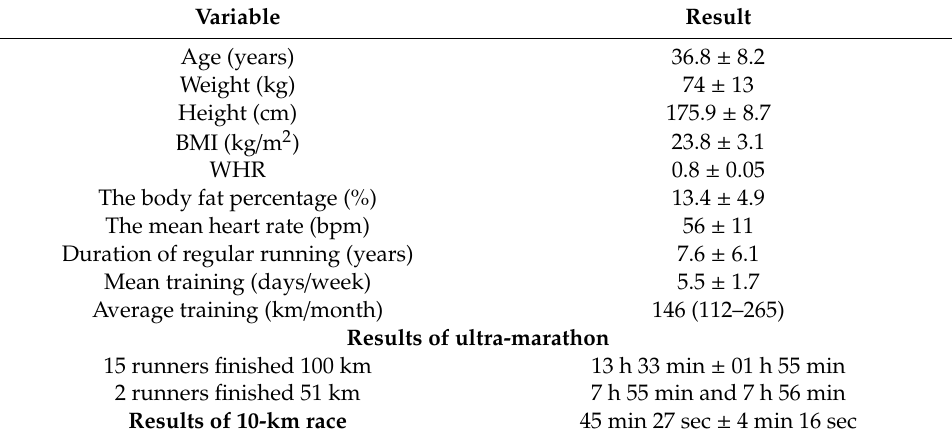
Table 2. General characteristics of the study group.